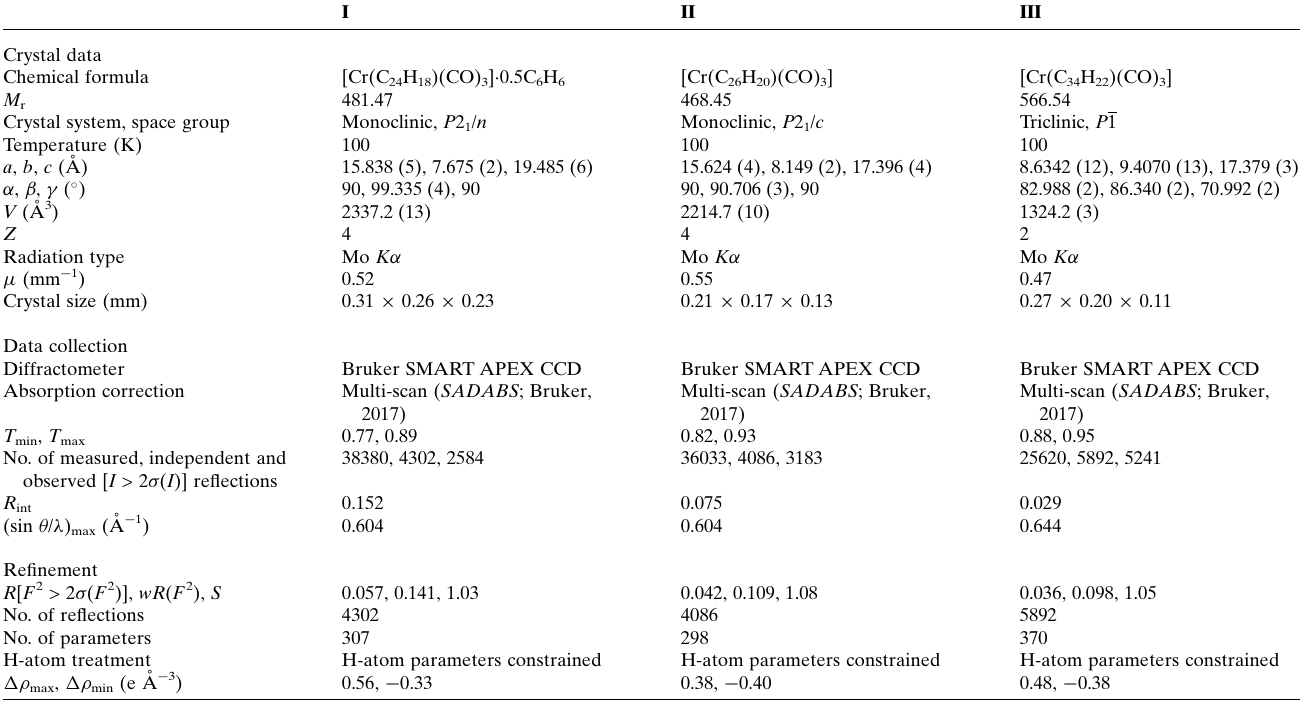
Crystal data Chemical